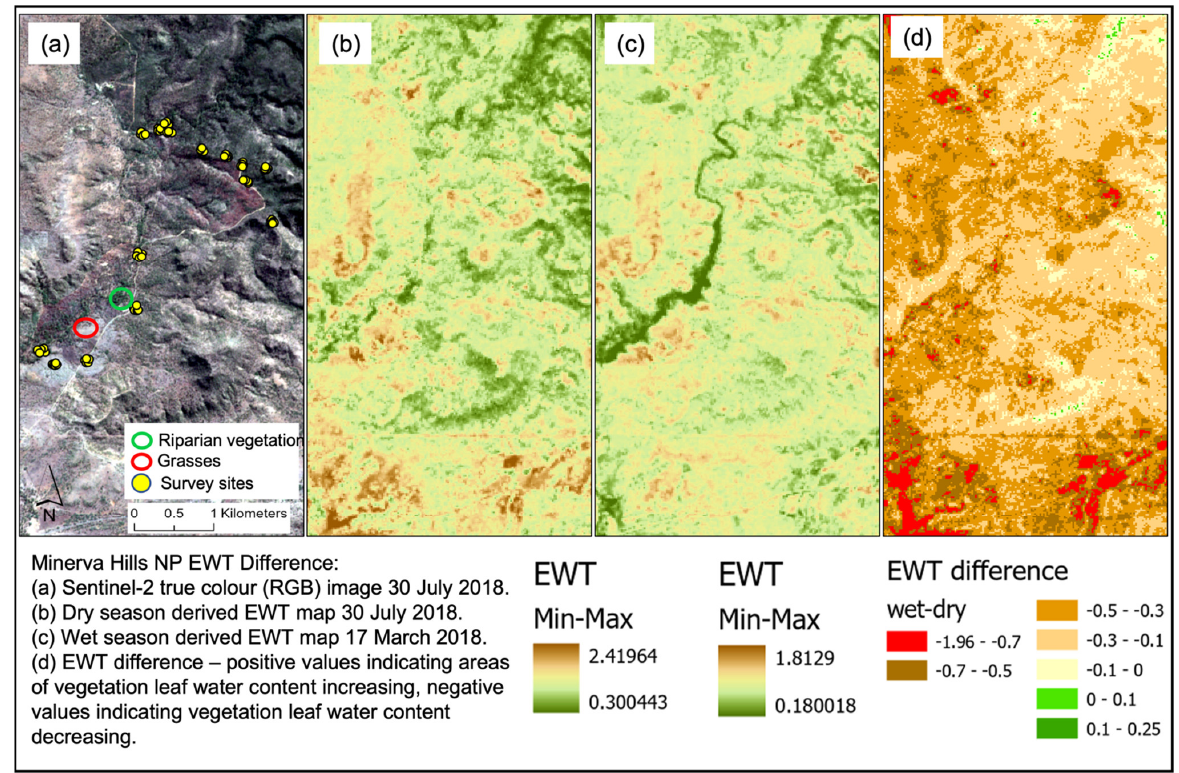
Figure A9. Minerva Hills NP EWT Difference.